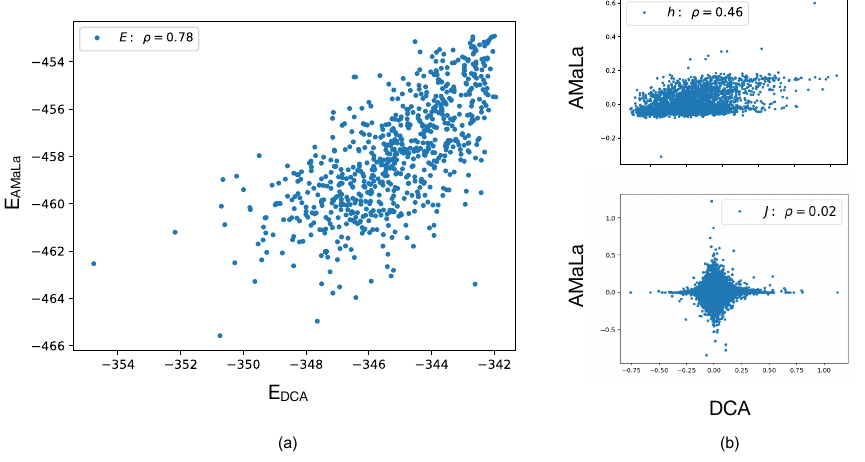
Figure 2. Model comparison between standard PlmDCA performed over the homology family (PF13354) and AMaLa inferred over [26] data restricted to residues corresponding to the homologues alignment. Panel ( a ) shows the scatter between the resulting total energies. Panel ( b ) displays the scatter plots of individual parameters. In the upper plot, the scatter among single-site fields h is reported, and in the lower one, among pair interaction coupling J . Even if energetic parameters display separately either low ( ρ h = 0.46) or no correlation at all ( ρ J = 0.01), the resulting energies are nonetheless significantly correlated, the Pearson coefficient being ρ E = 0.77. This underlines how the quantity encoding the relevant phenotypic information is indeed the total